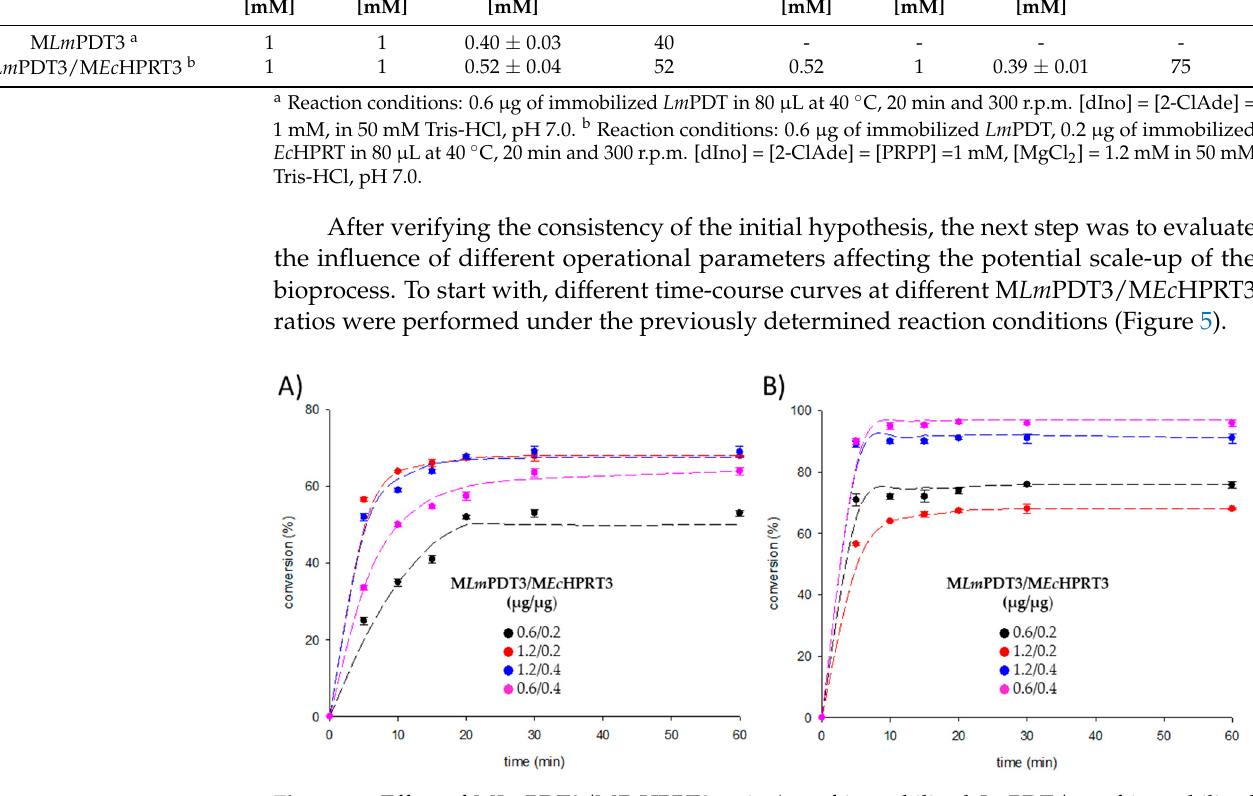
Figure 5. Effect of M Lm PDT3/M Ec HPRT3 ratio ( µ g of immobilized Lm PDT/ µ g of immobilized Ec HPRT) in the product formation. ( A ) cladribine (reaction 1). ( B ) Hyp converted into IMP (reaction 2).